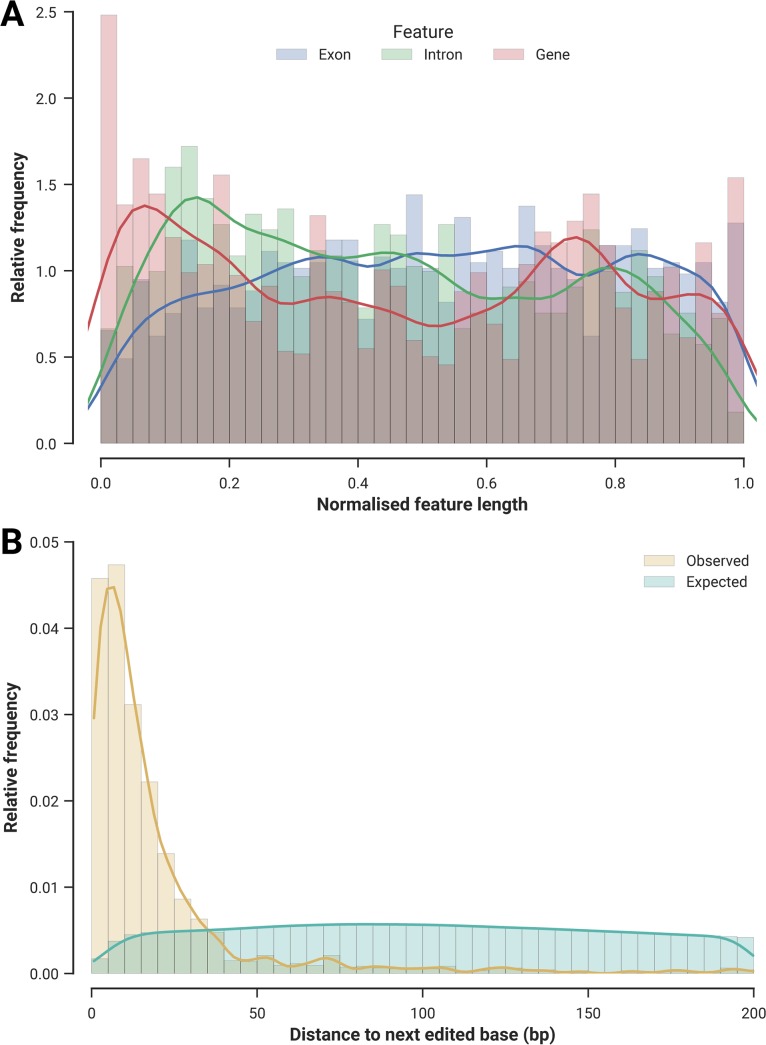
Distribution of edited sites.(A) Relative positions of the edited sites were tallied along the normalised lengths of exons (blue), introns (green) and genes (red). Each bar in the histogram covers a relative distance of 0.025. (B) Relative frequencies of distances to neighbouring edits. The observed distribution in S. microadriaticum (yellow) is contrasted with the expected distribution produced by 10,000 Monte Carlo simulations (cyan). Distributions were significantly different from each other (p < 10−300, χ2 test).